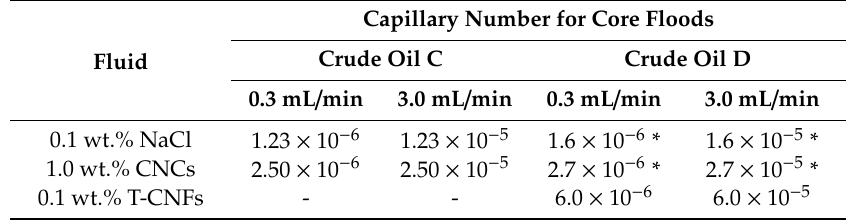
Table 8. Overview of capillary numbers for core floods. * The reported capillary number is an average based on all the floods conducted with the respective fluid. For these floods, the capillary numbers were all in the same order of